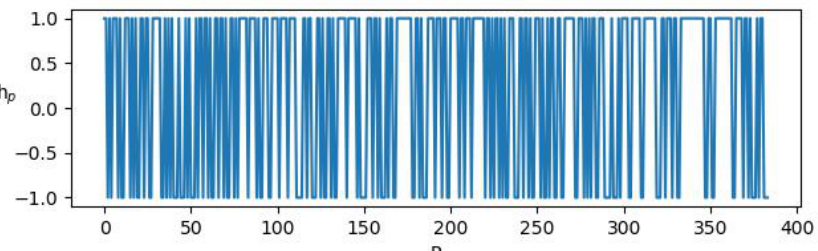
Figure 10. The single objective method fits the output unit’s fluctuations during training.